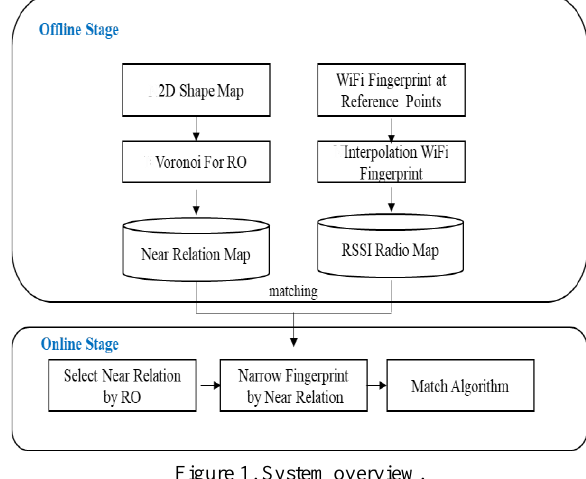
Figure 1. System overview.